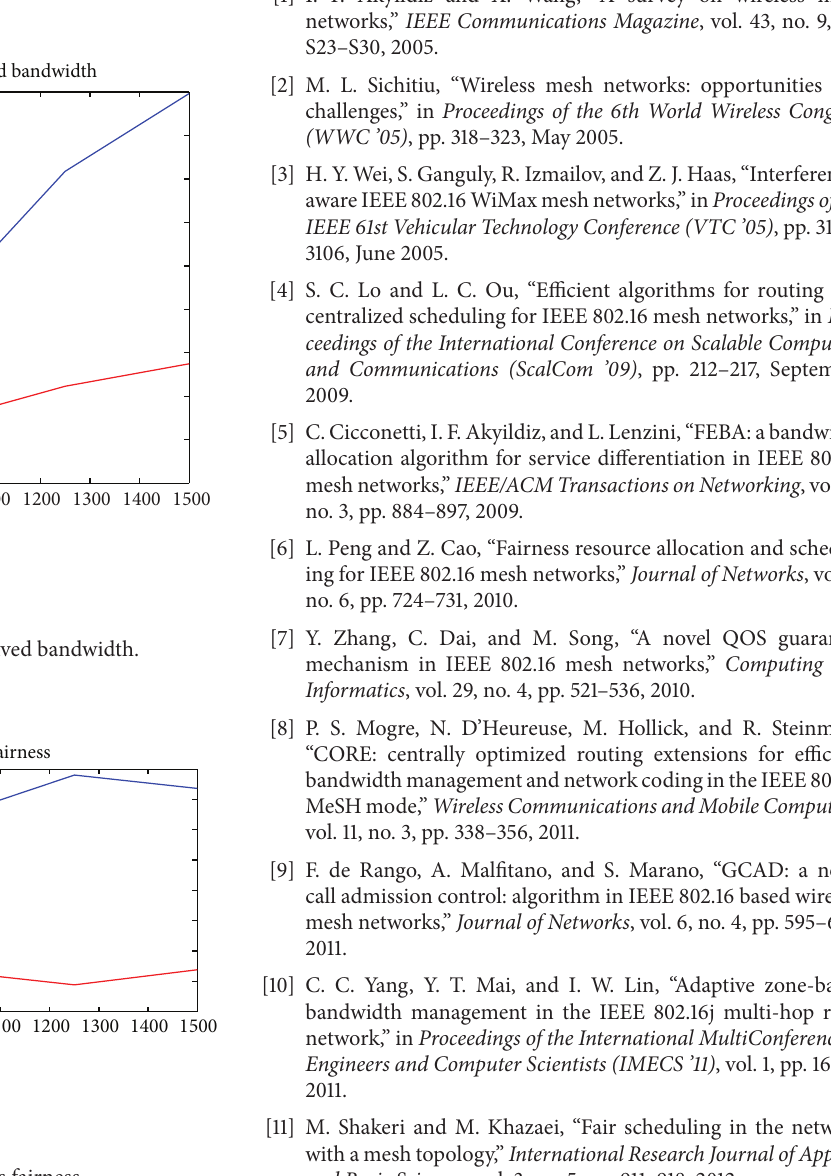
Figure 5: Packet size versus delay.